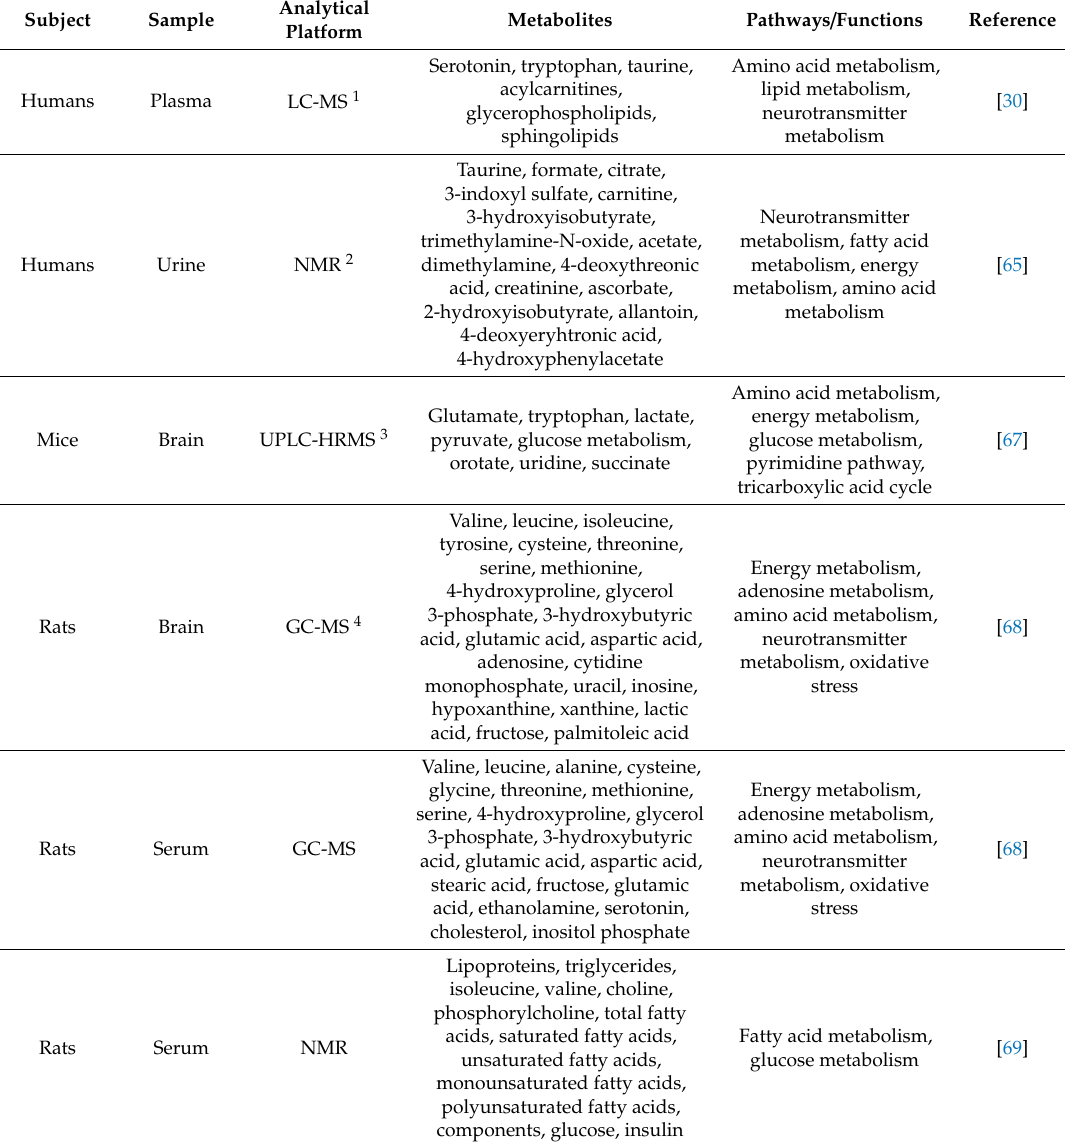
Table 2. Possible biomarkers identified in sleep-deprived